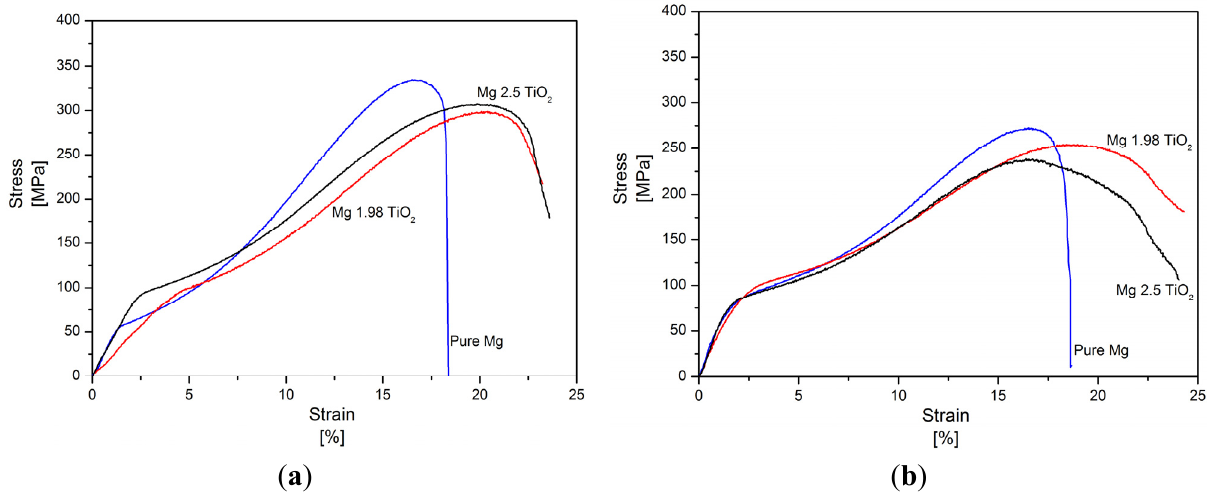
Figure 5. Stress–Strain curves of ( a ) DMD and ( b ) PM synthesized pure Mg and Mg-TiO